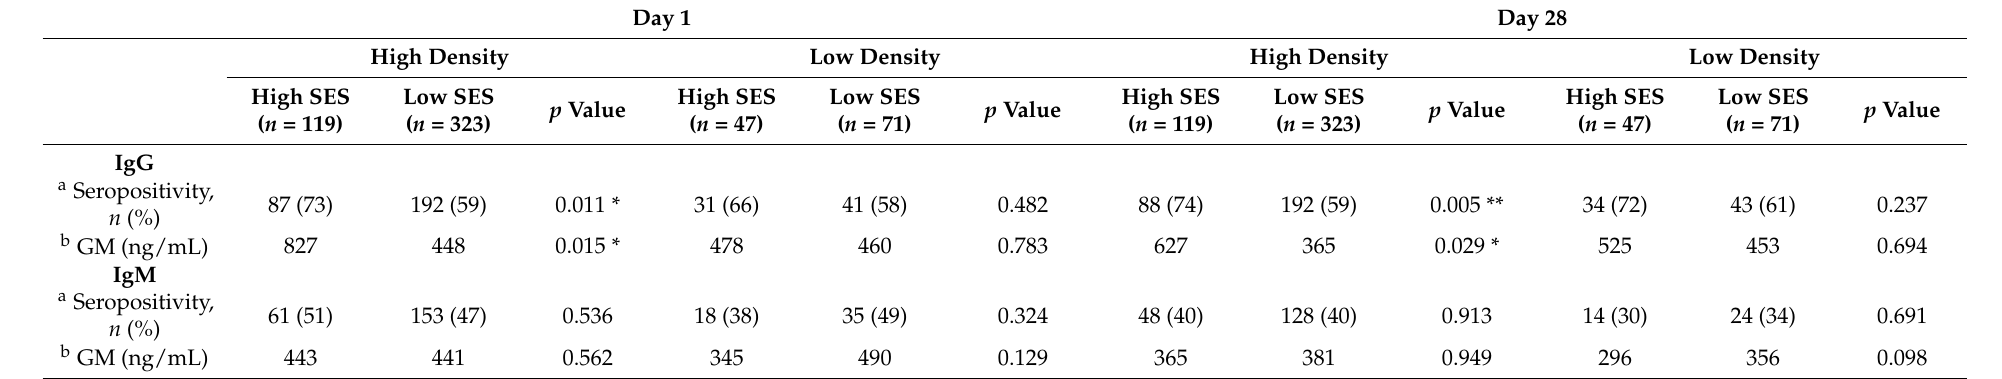
Table 4. Seropositivity and level of SARS-CoV-2 antibodies in high- and low-SES people living in high- and low-density areas of Dhaka